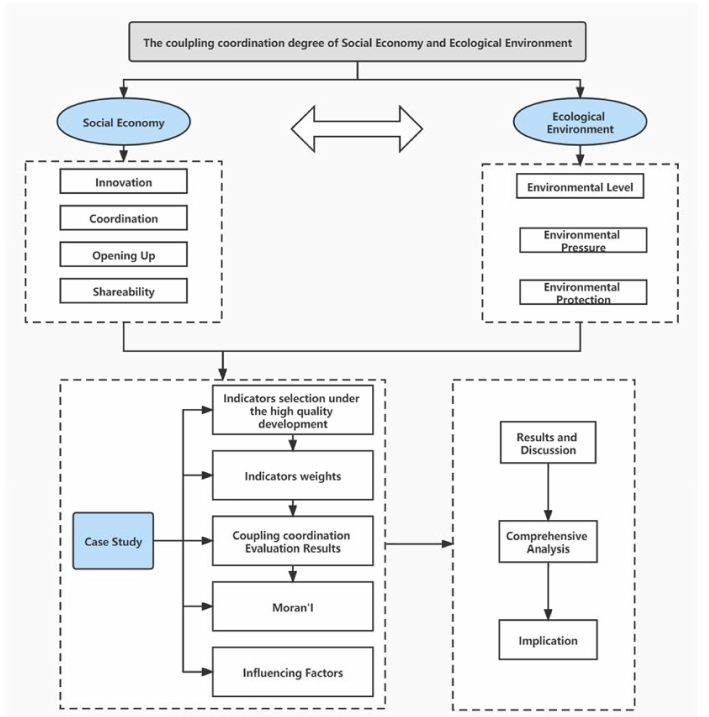
Figure 3. The framework of measurement of coupling coordination degree and spatio-temporal characteristics of the social economy and ecological